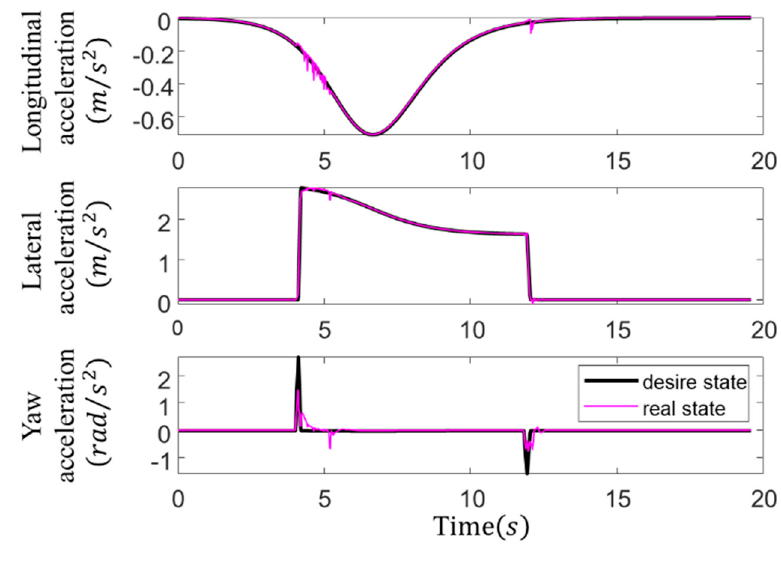
Figure 8. The vehicle dynamic states tracking results in scenario 2. Appl. Sci. 2020 , 10 , x FOR PEER REVIEW